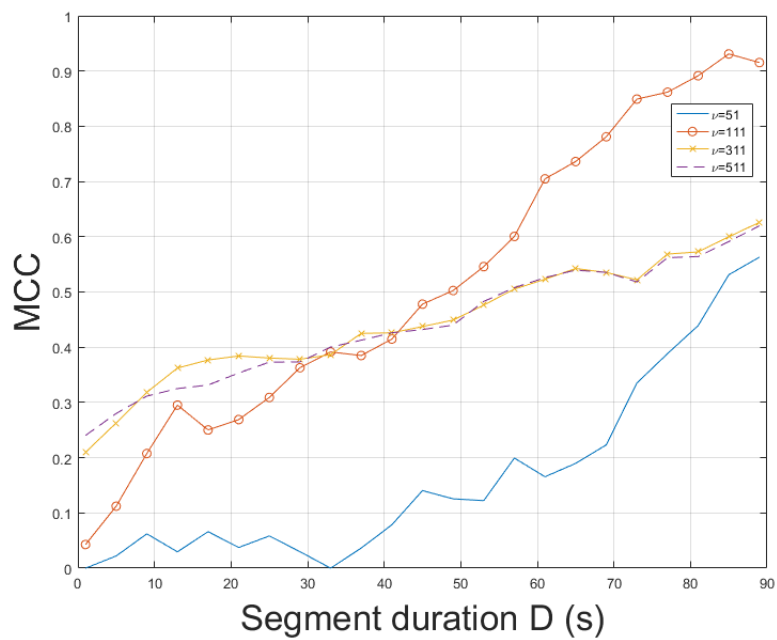
Figure 13. Maximum correlation coefficient of the proposed approach employing SLIC+STFT for various bandpass filter orders and segment durations